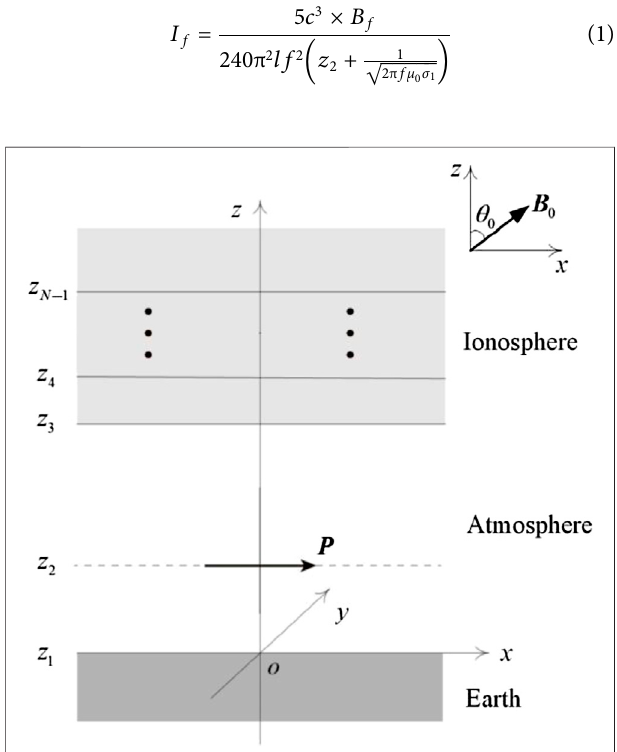
FIGURE 7 | Propagation model of waves radiated from a dipole above the